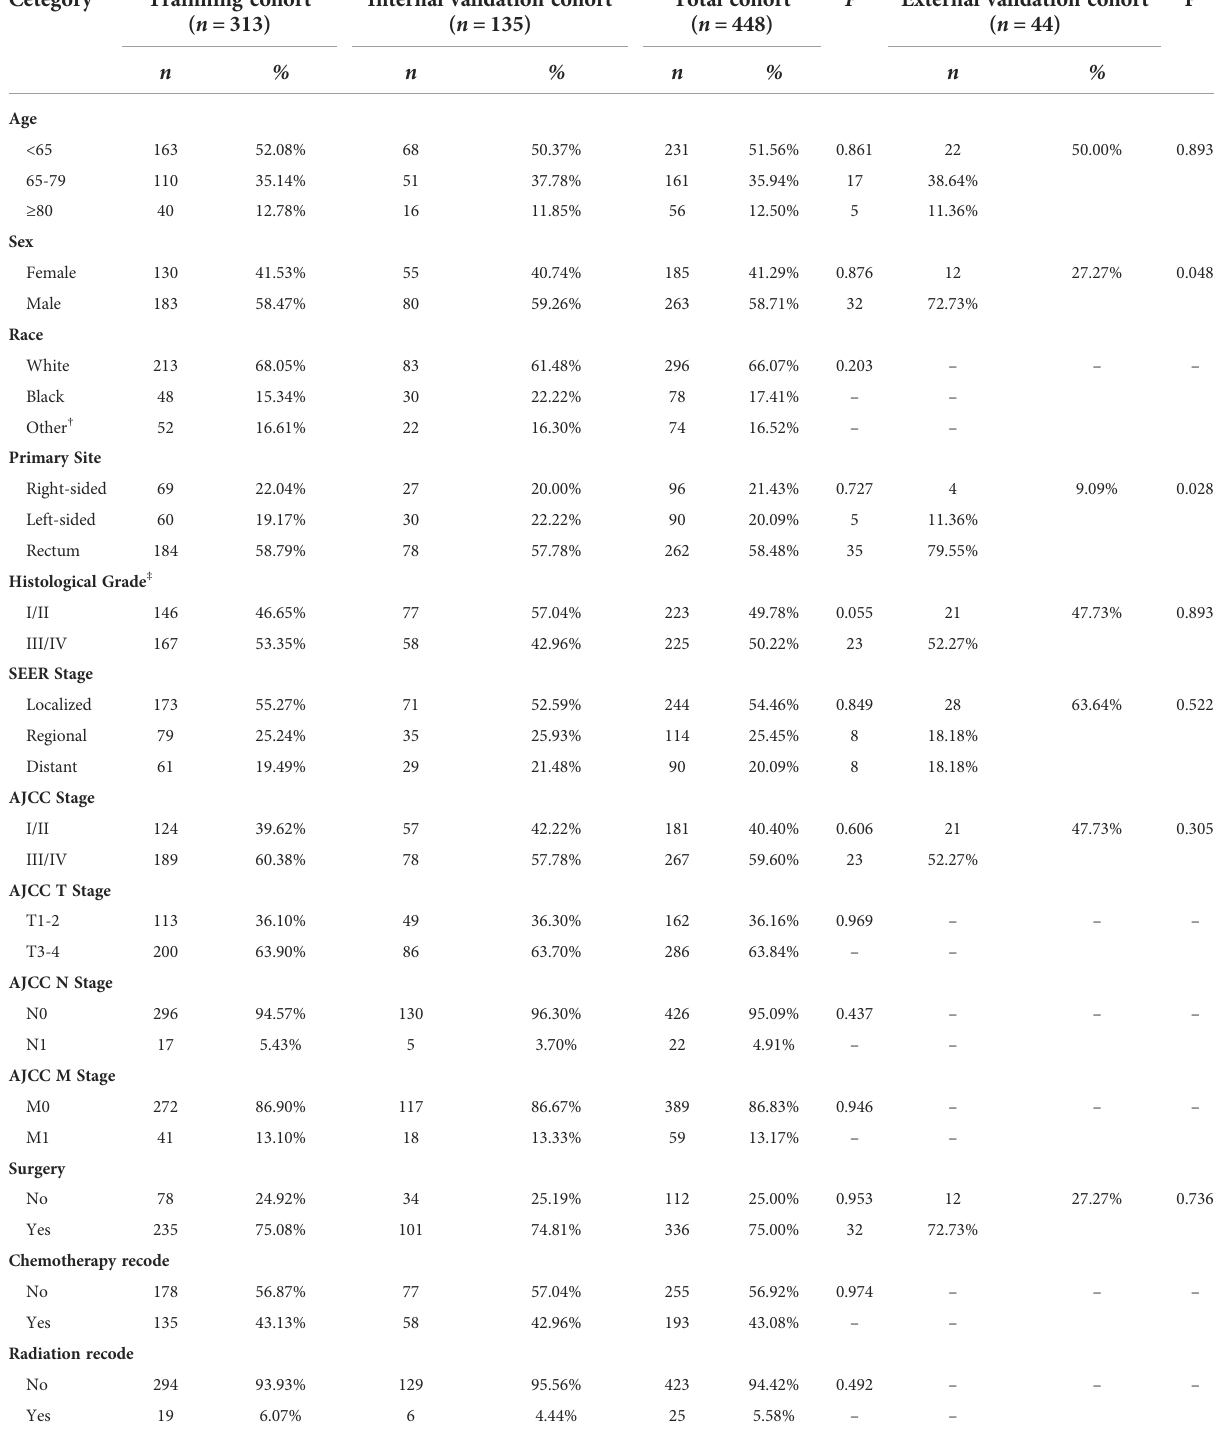
TABLE 1 Demographics and Clinicopathologic Characterisitcs of Patients with Colorectal GISTs.